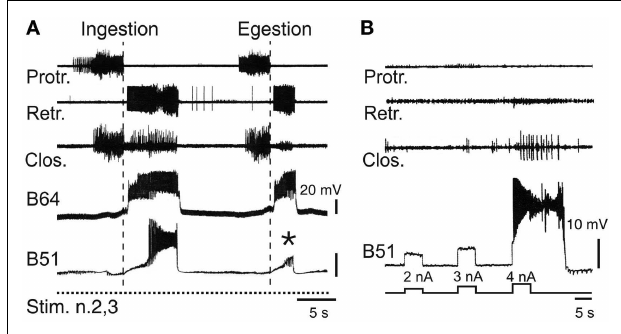
FIGURE 5 | Neuronal correlates of spontaneous motor pattern switching. (A) Extracellular recordings of radula motor patterns (top three traces) and intracellular recordings of the essential B64 neuron and the optional B51 cell of the retractor generator. Switching between ingestion and egestion motor patterns during tonic (2Hz) stimulation of n.2,3 (Stim. n.2,3) was associated with the spontaneous, all-or-none activation or absence ( ∗ ) of bursting in B51. (B) Endogenous plateau property of B51 revealed by brief intracellular current injections in the absence of n.2,3 stimulation. Note that a burst-generating plateau in B51 also elicited closure motor activity that normally occurs during the retraction phase of ingestion patterns [see (A)